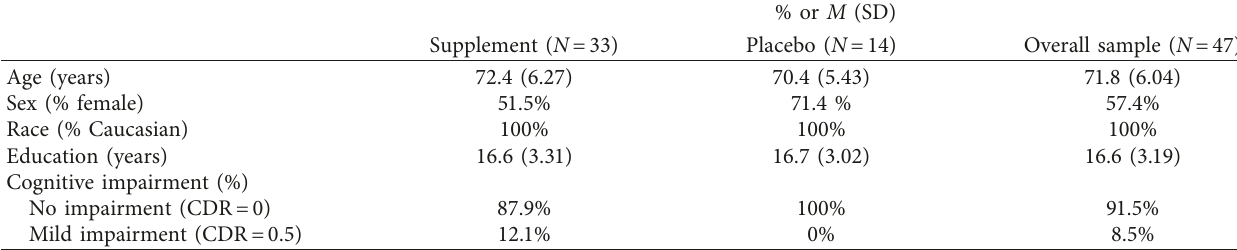
Table 1: Preintervention characteristics.